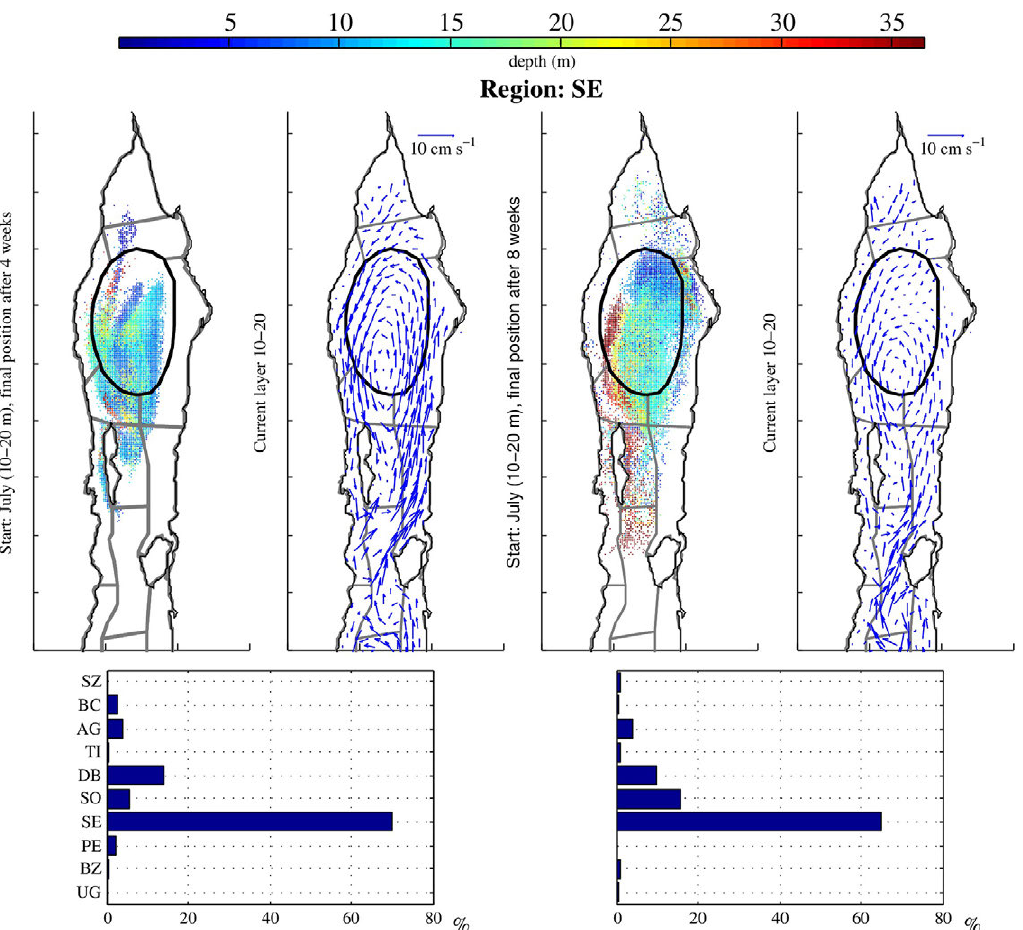
Fig. 5. – Map of final positions of particles released in the Seasonal Eddy’s second layer, in the fourth and eighth week after the release of particles. The release area is shown in black and the other areas in grey polygon. The colour bar represents the depth at which each particle is located. The histogram shows the percentage of particles retained or transferred to other regions. Current maps correspond to the layer in which the percentage of particles retained is concentrated, in the fourth and eighth week after particle